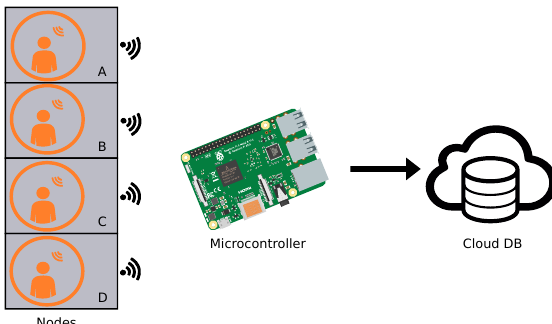
Figure 1. Configuration of the deployed IoT sensing